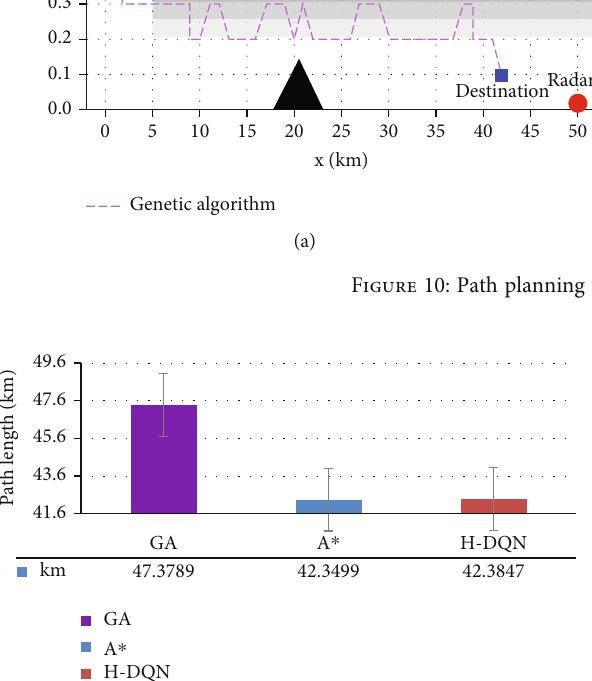
Figure 11: Comparison of path length obtained for GA, A ∗ , and H-DQN algorithms. The interval on each bar denotes the standard deviation of the path length.